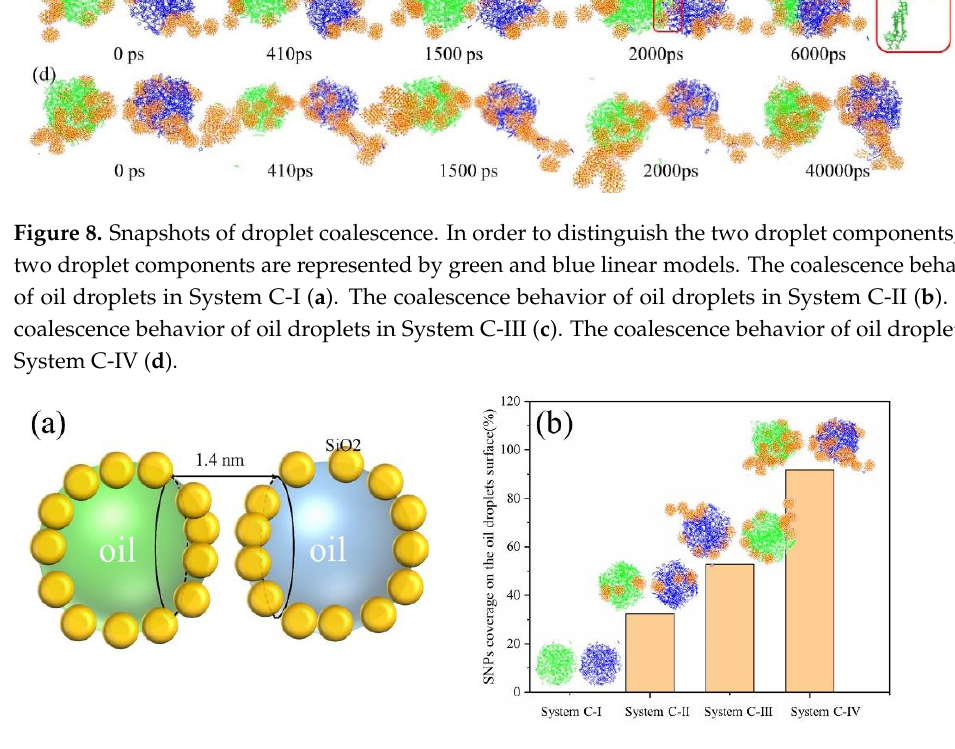
Figure 8. Snapshots of droplet coalescence. In order to distinguish the two droplet components, the two droplet components are represented by green and blue linear models. The coalescence behavior of oil droplets in System C-I ( a ). The coalescence behavior of oil droplets in System C-II ( b ). The coalescence behavior of oil droplets in System C-III ( c ). The coalescence behavior of oil droplets in System C-IV ( d ).